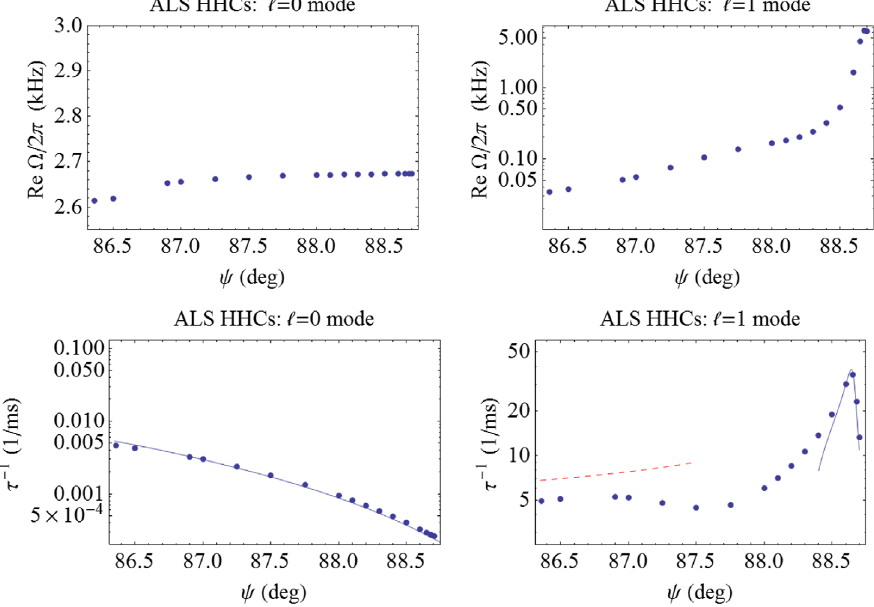
FIG. 1. The two pictures on the right capture the main result of this paper. Shown are the real (top) and imaginary Im Ω ≡ τ − 1 part (bottom) of the complex-number frequency for mode l ¼ 1 if two of the existing ALS HHCs are to be used in ALS-U. The quantities are plotted vs. the tuning angle ψ ¼ 2 Q ð ω r − ω 3 Þ = ω 3 . The lower end in the tuning angle ψ ¼ 86 : 5 o , where the HHCs would be expected to operate, corresponds to about a factor 4 bunch lengthening. At that setting, the growth rate of the instability is about 5 ms − 1 (or 0.2 ms growth time) while the oscillation frequency is less than 50 Hz (or 20 ms period); the large disparity between the two characteristic times places the instability out of reach of existing longitudinal feedback system. The pictures to the left are for the much more benign l ¼ 0 (Robinson ’ s) instability. Note that for this instability the oscillation frequency of the mode remains very close to the synchrotron oscillation frequency in the absence of HHCs (about 2.7 kHz, see Table I). See the text for the meaning of the curves in the bottom pictures.